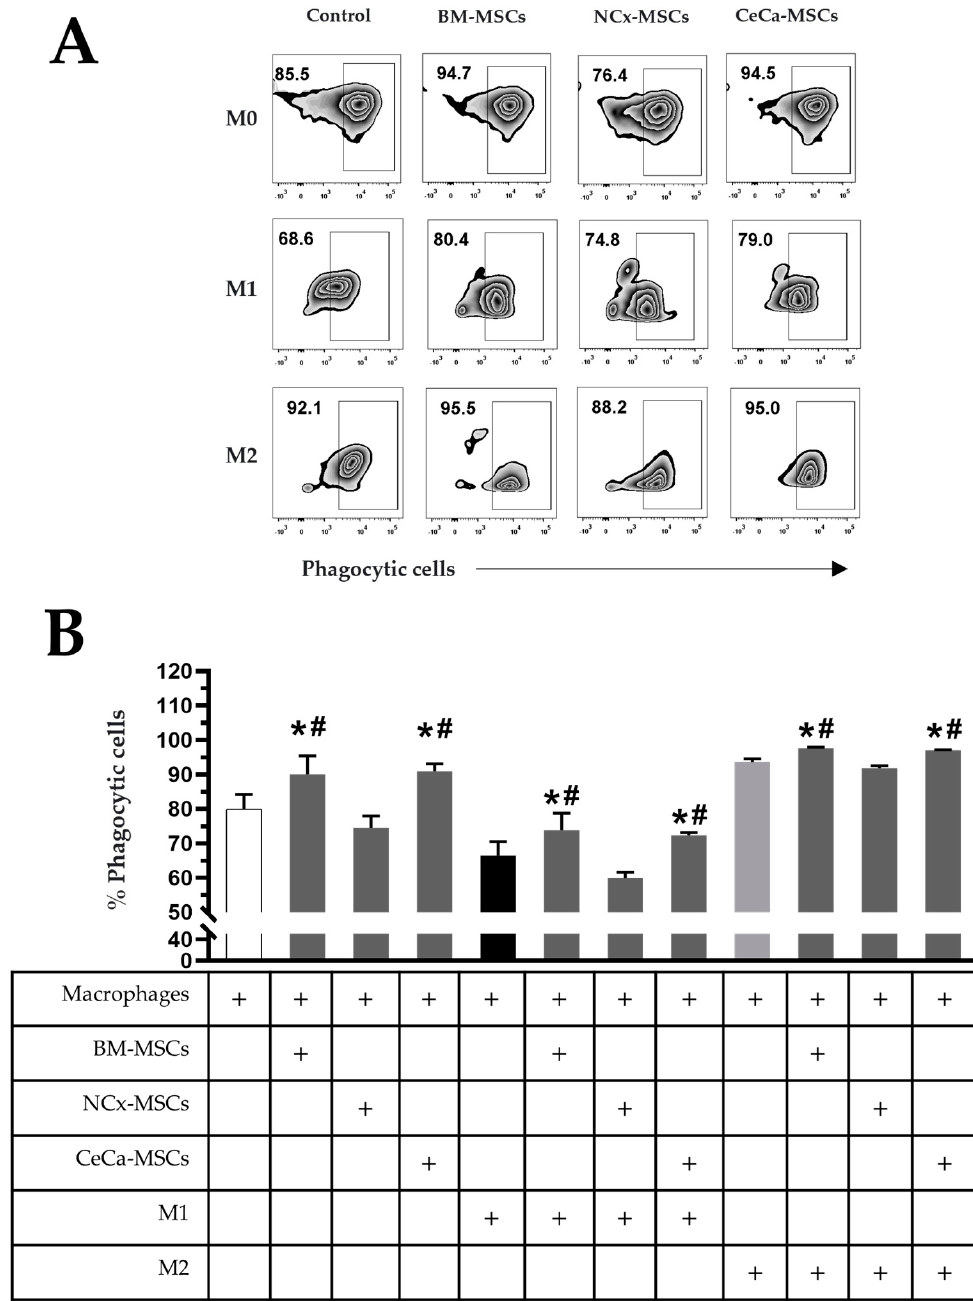
Figure 2. CeCa-MSCs, unlike NCx-MSCs, increase the phagocytosis capacity of macrophages. ( A ) Plot representative of the percentage of phagocytic cells. ( B ) Bar graph of the mean percent- age of phagocytic cells evaluated with E. coli bioparticles. Bar graphs represent the mean and standard deviation. * Significant difference with respect to the control, # significant difference with respect to NCx-MSCs ( p < 0.05); n = 6. M0, absence of inducer medium; M1, inducer medium for M1 polarization; M2, inducer medium for M2